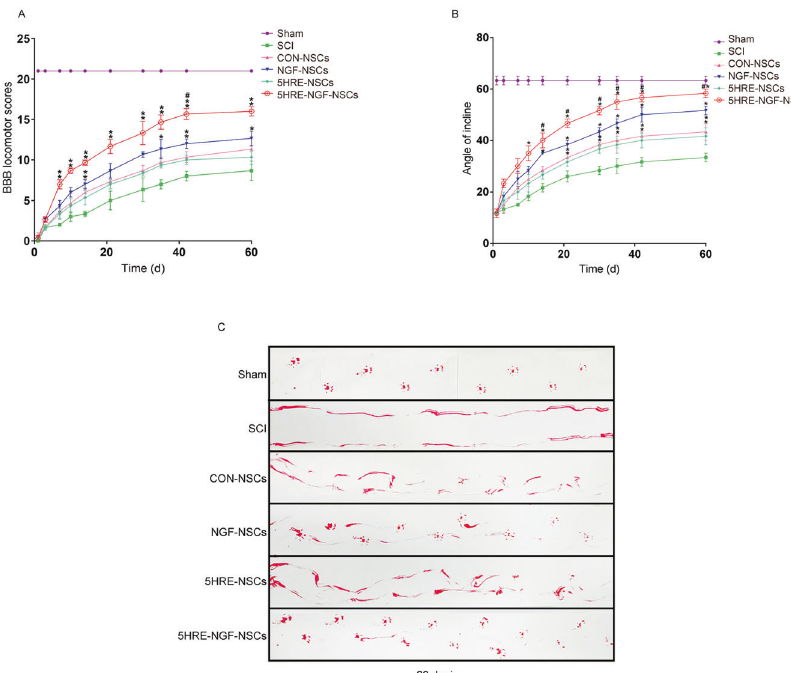
Fig. 4 AAV-5HRE-NGF-NSCs enhanced the recovery after injury. A BBB rating scores of Sham, SCI, CON-NSCs, NGF-NSCs, 5HRE-NSCs, 5HRE- NGF-NSCs groups. The Sham group scores the highest point of 21, meaning a normal function. * is representative of P < 0.05 and ** of P < 0.01 versus the SCI group, # represents P < 0.05 versus the NGF-NSCs group. Data are the mean values ± SD, n = 6. B Inclined plane test scores of Sham, SCI, CON-NSCs, NGF-NSCs, 5HRE- NSCs, 5HRE-NGF-NSCs groups. * is representative of P < 0.05 and ** of P < 0.01 versus the SCI group, # represents P < 0.05 versus the NGF-NSCs group. Data are the mean values ± SD, n = 6. C Footprint analyses of Sham, SCI, CON-NSCs, NGF-NSCs, 5HRE -NSCs, 5HRE-NGF-NSCs groups. Sham group shows the normal movement. SCI group signi fi es the hind limbs dysfunction after